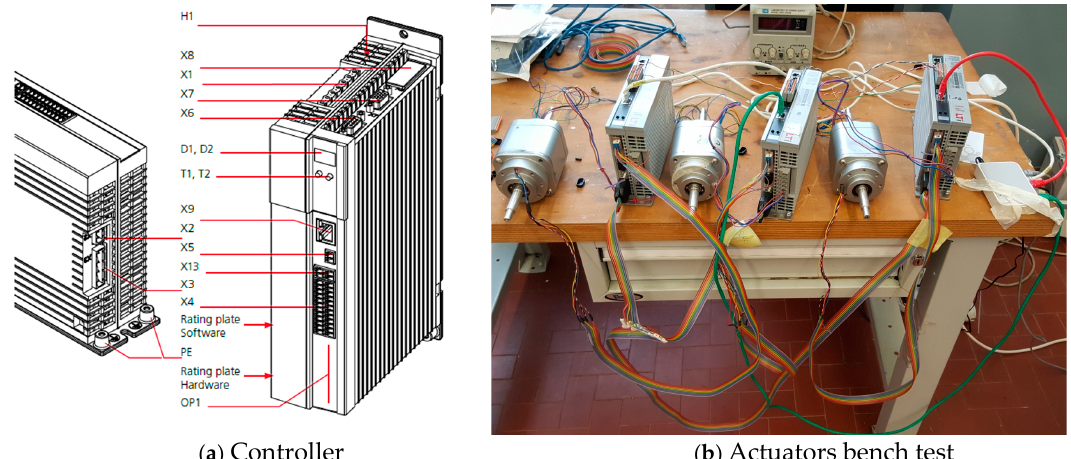
Figure 12. Control units of brushless motors.